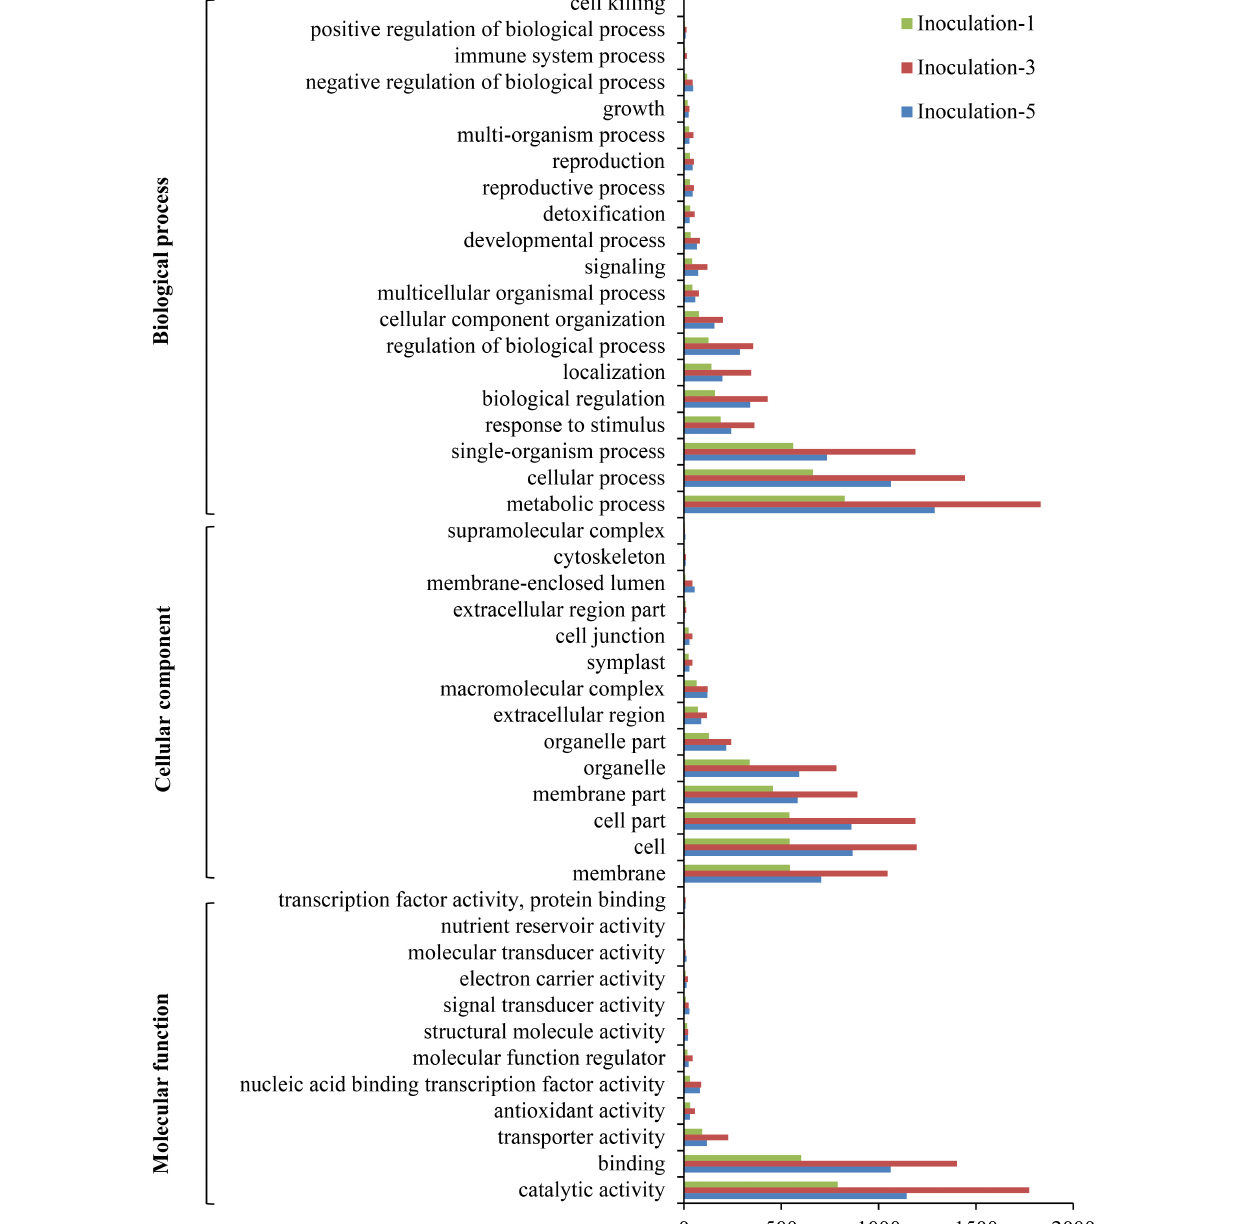
template 5 µ L, and ddH 2 O supplemented to 20 µ L. Reaction conditions are as follows: pre-denaturation at 95 ◦ C for 30